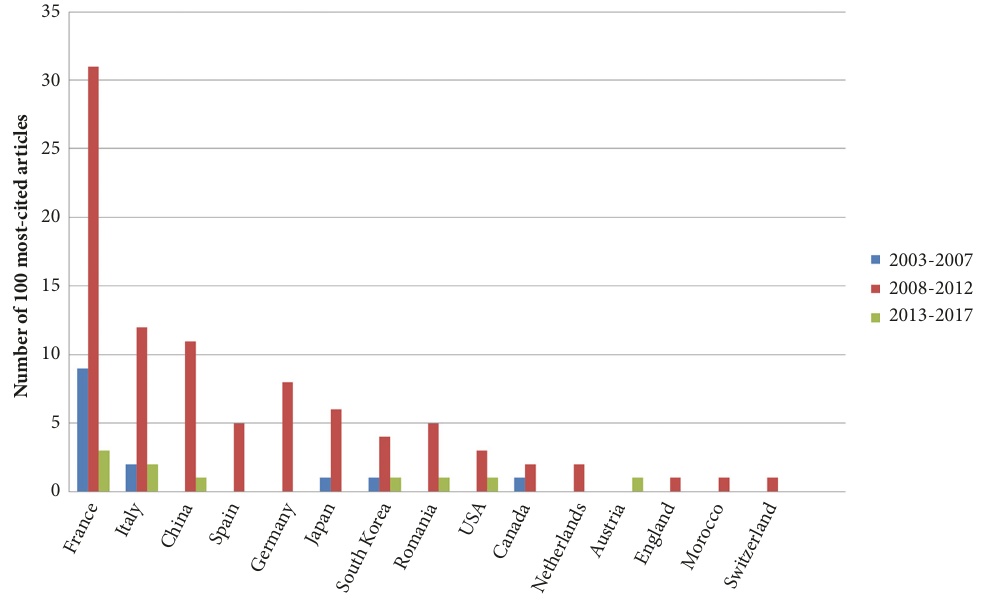
Figure 4: Conditions of transient elastography's research in different countries over time. The number of most-cited articles in each country in three periods which are represented by three colors: the period from 2003 to 2007 (blue), the period from 2008 to 2012 (red), and the period from 2013 to 2017 (green). If no article was on the list of the 100 most-cited articles from a particular country in a certain period, there will be no bar referring to that country shown in the